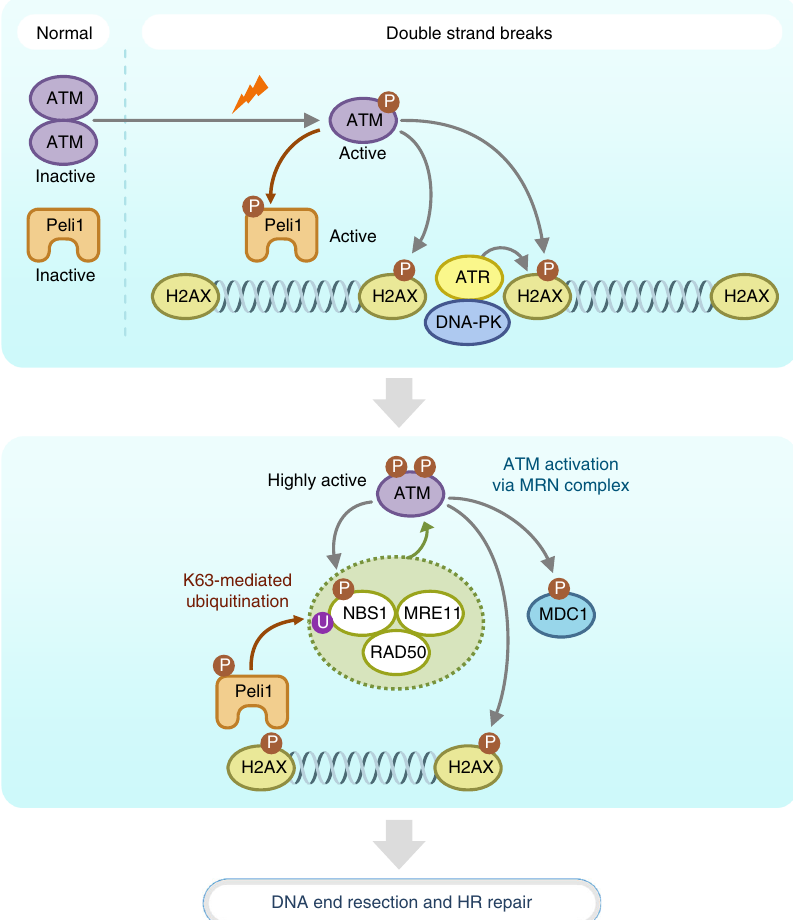
Fig. 10 Model of Peli1-mediated DNA damage signaling and HR repair. Peli1 recruitment to DSB sites is triggered by ATM-mediated phosphorylation and directly binds to phosphorylated histone H2AX (Step I). Once recruited, Peli1 interacts with NBS1 and catalyzes K63-linked ubiquitination of NBS1, leading to further activation of ATM, which reinforces DNA-end resection and HR repair (Step